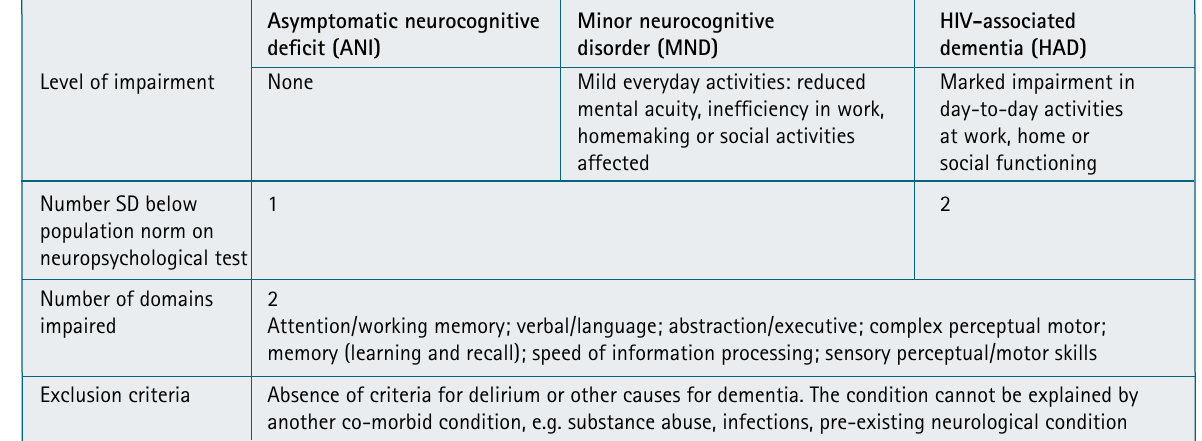
taBle i. cRiteRia FOR HiV-aSSOciated neUROcOGnitVe